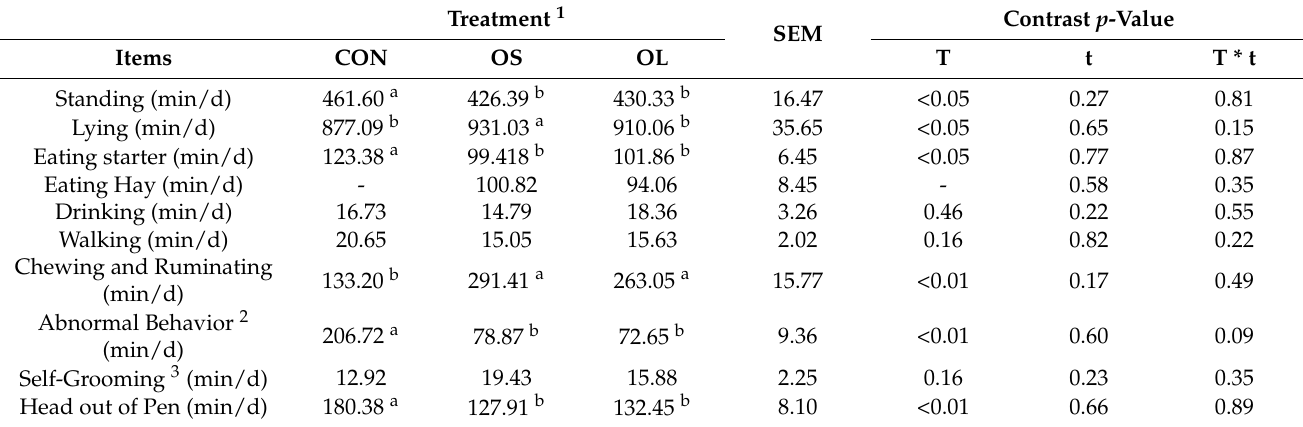
Table 6. Effects of different lengths of hay supplementation on calf’s